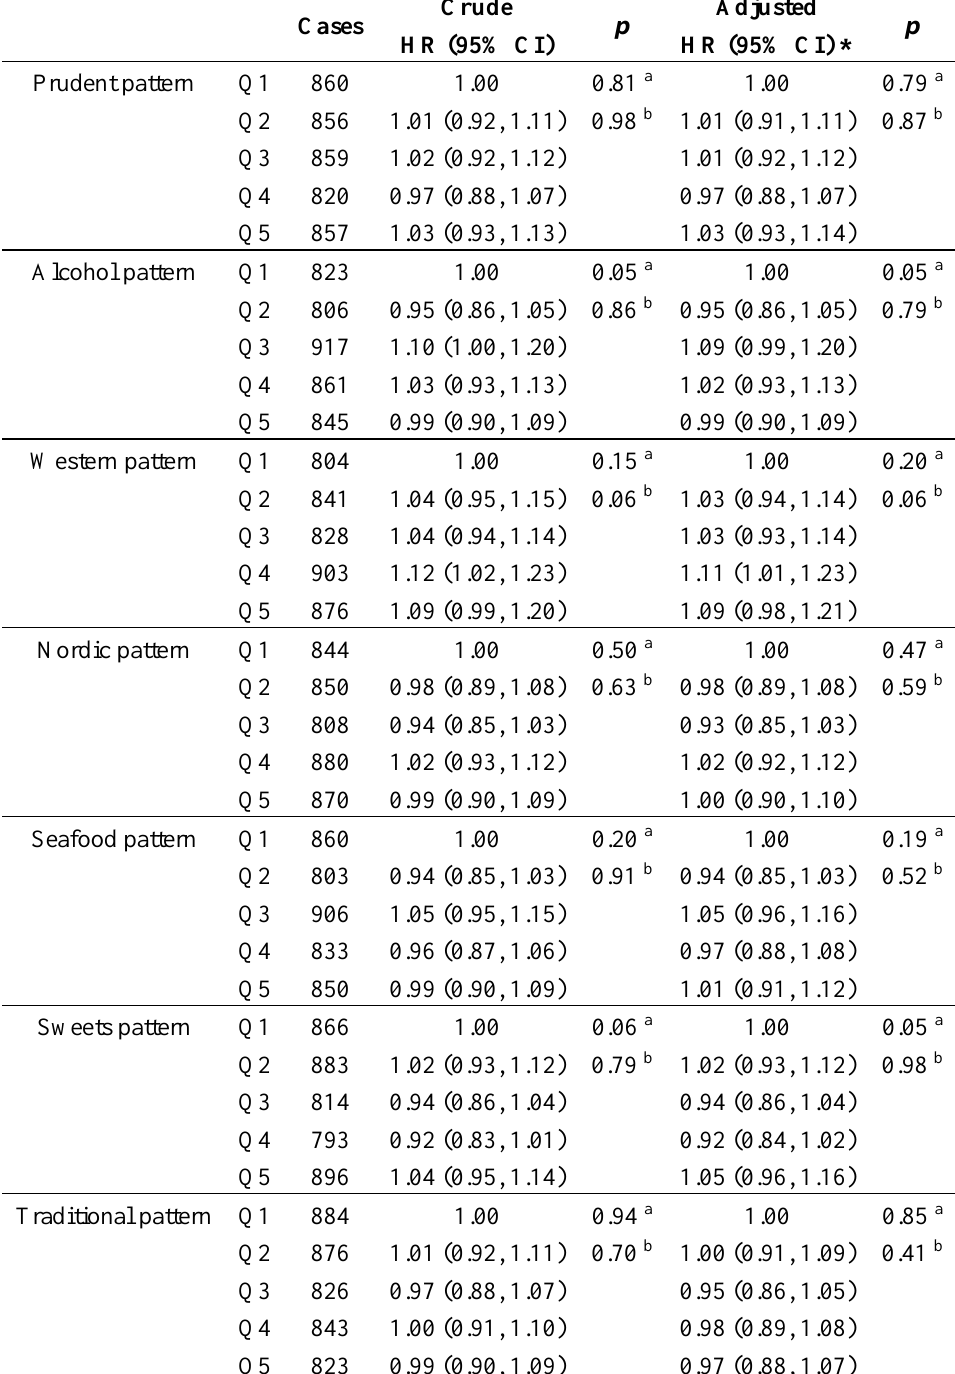
Table 3. Hazard ratios (HRs) of offspring forearm fractures in the Danish National Birth Cohort according to maternal dietary patterns in mid-pregnancy ( n =